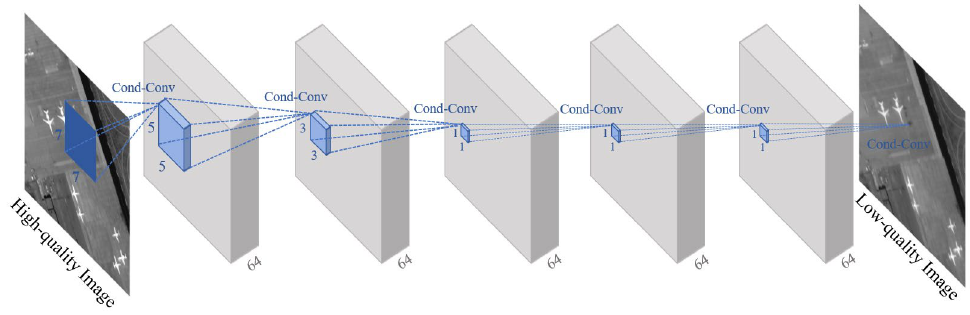
Figure 5. The architecture of the proposed conditional convolutional neural network (CCNN).